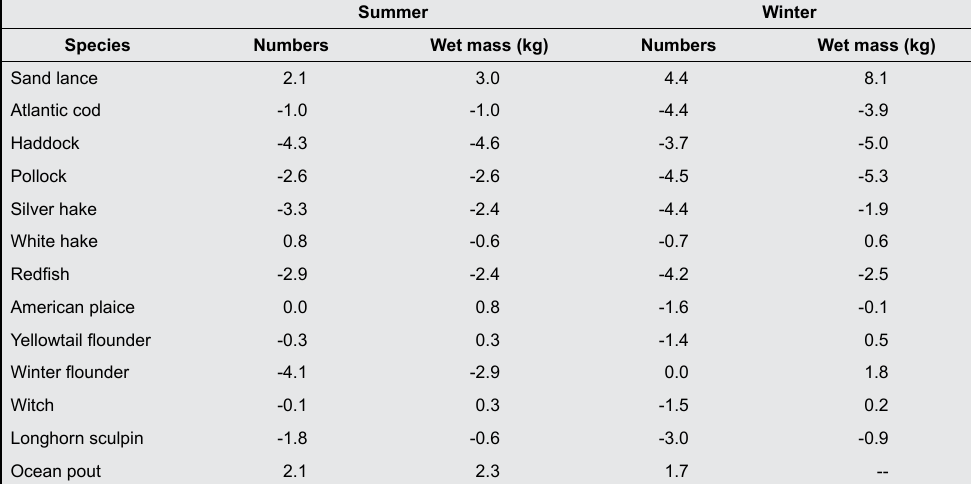
Table 6. Log-odds ratios of selected prey in the diet of grey seals, based on numbers and wet weight, during summer and winter, 1991-1997 data